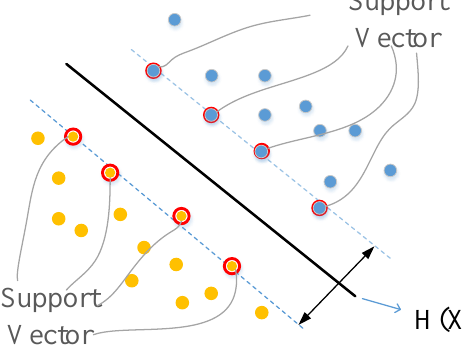
Figure 4. Two categories of Support Vector